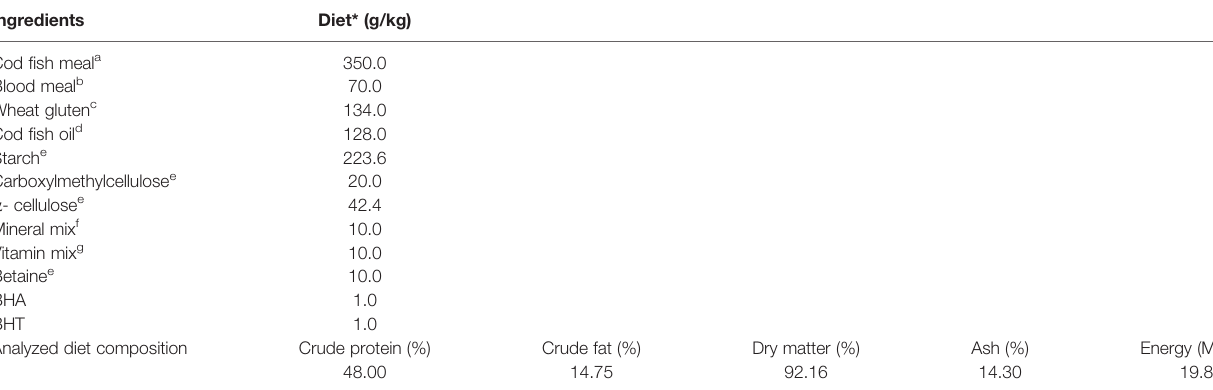
TABLE 1 | Ingredients and proximate composition of the experimental pelleted diet.